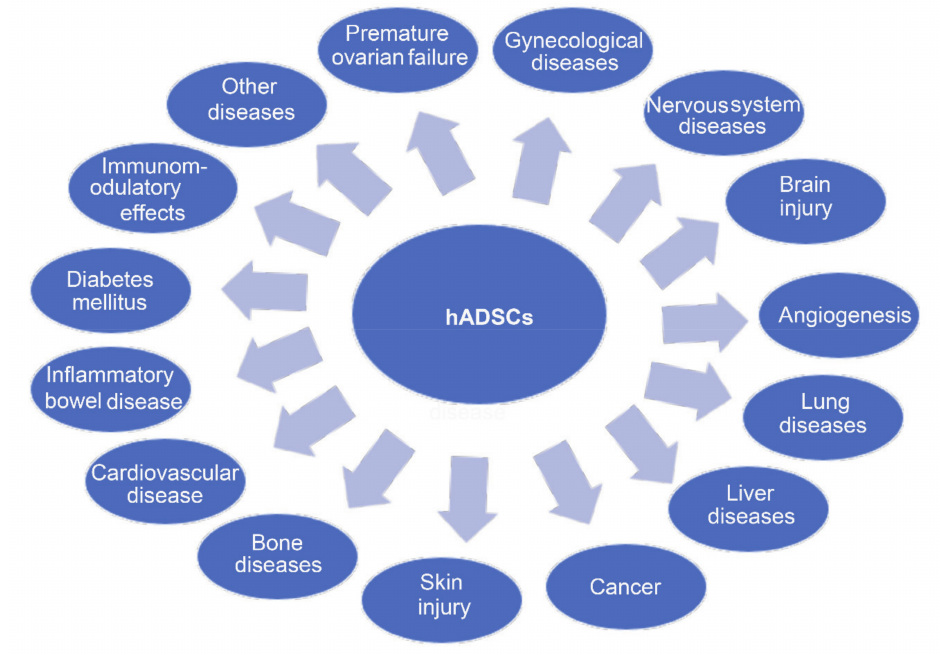
Figure 3. Diseases have been treated by